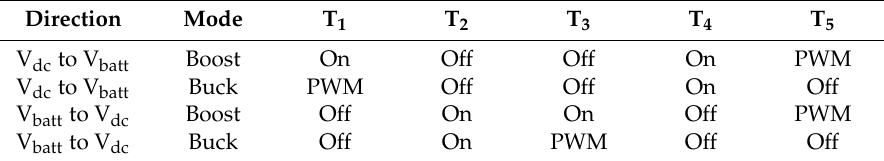
Figure 41. Universal DC-DC converter [72]. Table 22. Operating conditions for universal DC-DC converter. Adapted from [88].